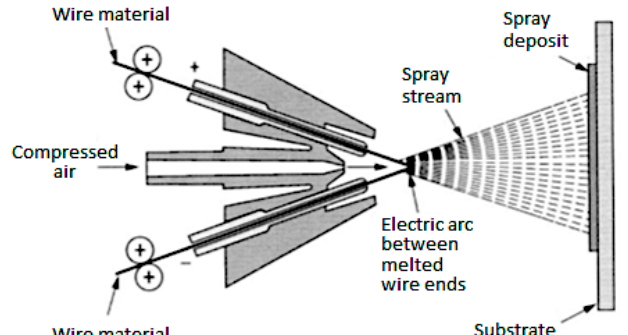
Figure 2. Model of arc spraying.